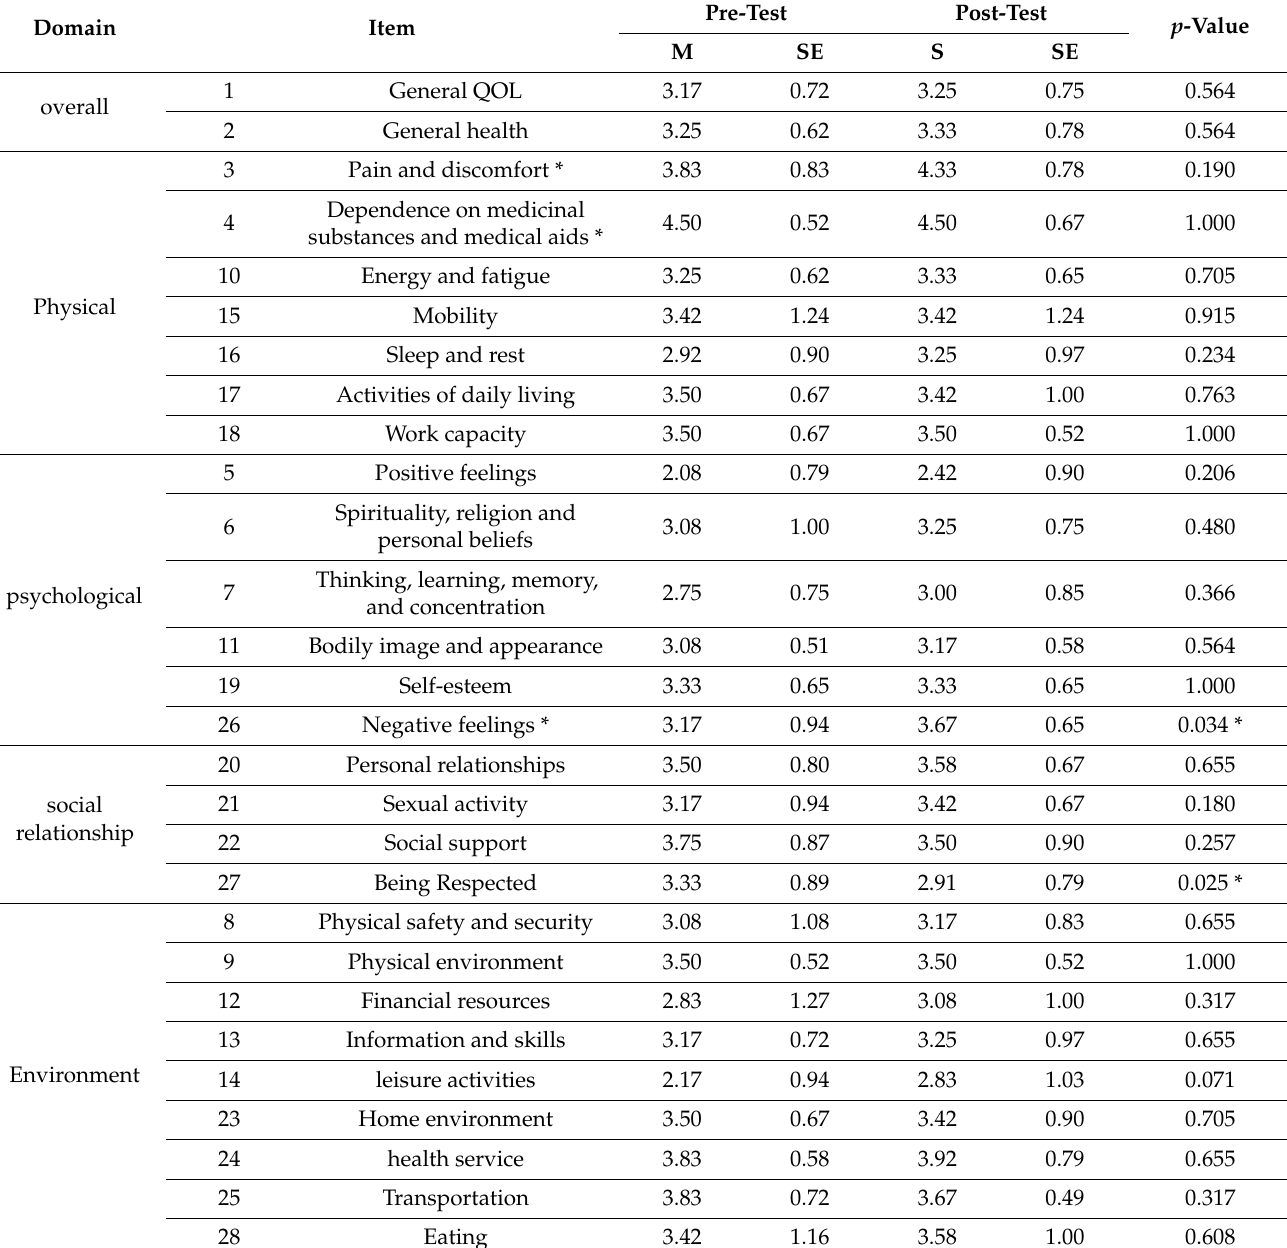
Table A1. Wilcoxon signed ranked Test with WHOQOL-BREF Taiwan version items (N =